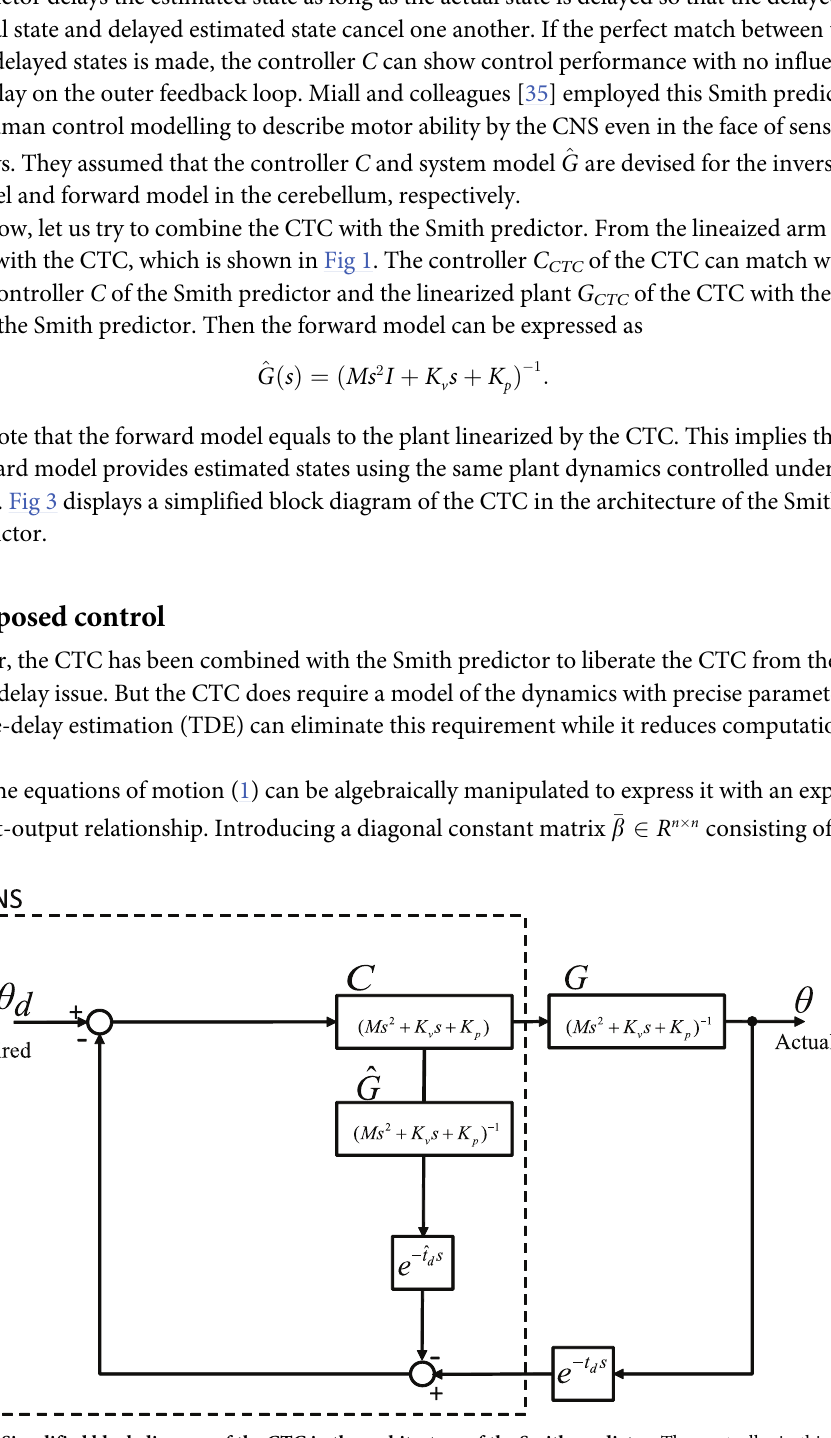
Fig 3. Simplified block diagram of the CTC in the architecture of the Smith predictor. The controller in this control architecture can match with the controller C of the Smith predictor and the linearized plant of the CTC with the plant G of the Smith predictor. The forward model equals to the plant linearized by the CTC. This control architecture compares the actual position that is delayed in feedback loop with its estimate that is intentionally delayed. The difference between them is compared with the desired